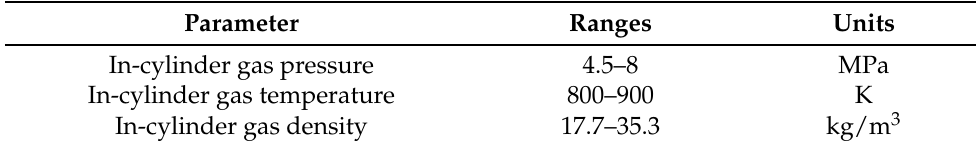
Table 1. Ranges of the operating